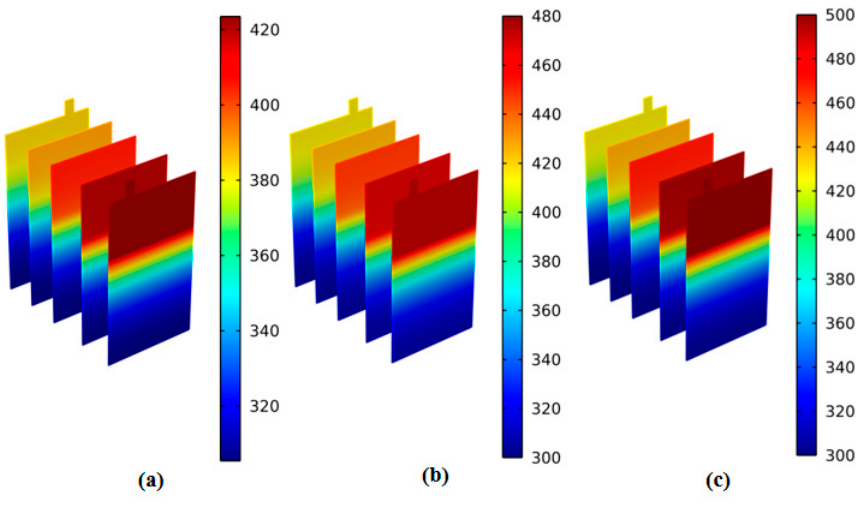
Figure 10. Temperature distribution of each part of the battery for 300 s: ( a ) 423.15 K; ( b ) 473.15 K; and ( c ) 523.15 K.